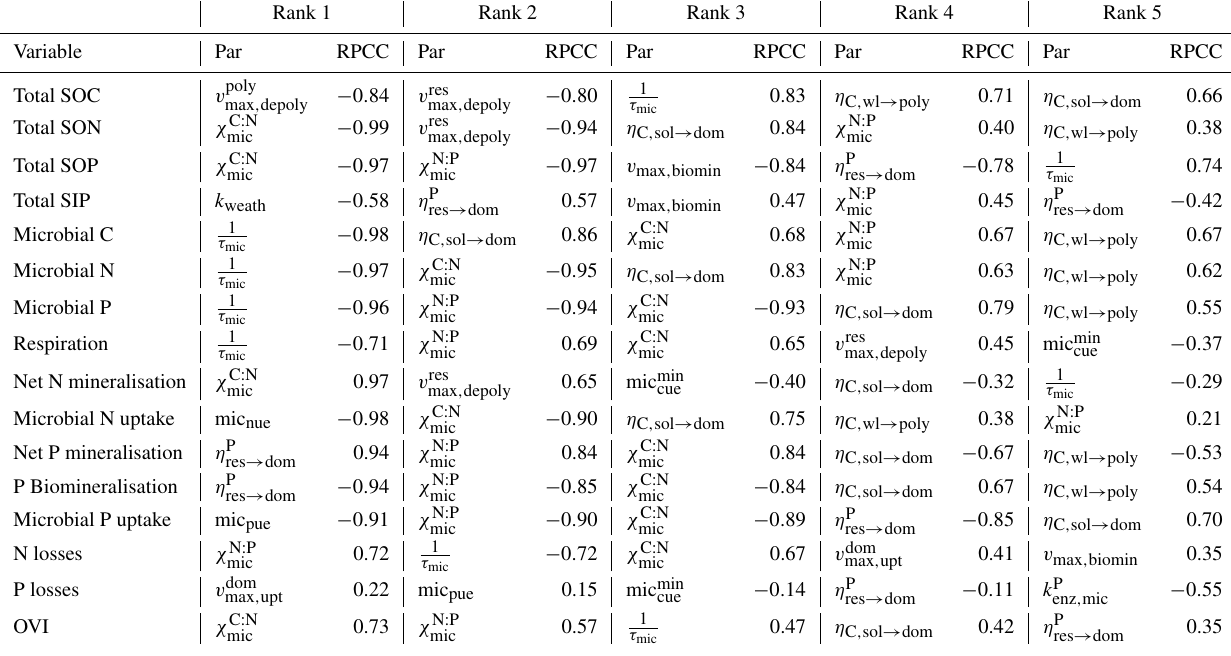
Table 2. The five most important parameters (Par) and their respective RPCCs for each output variable and the overall model importance (OVI). RPCCs were calculated for each output variable, and the overall importance of parameters was measured by calculating the mean of the absolute RPCCs across all output variables, weighted by the uncertainty contribution of these model outputs. The parameters are listed in Table S2 and explained in Table S1. SOP: soil organic phosphorus; SIP: soil inorganic phosphorus; SON: soil organic